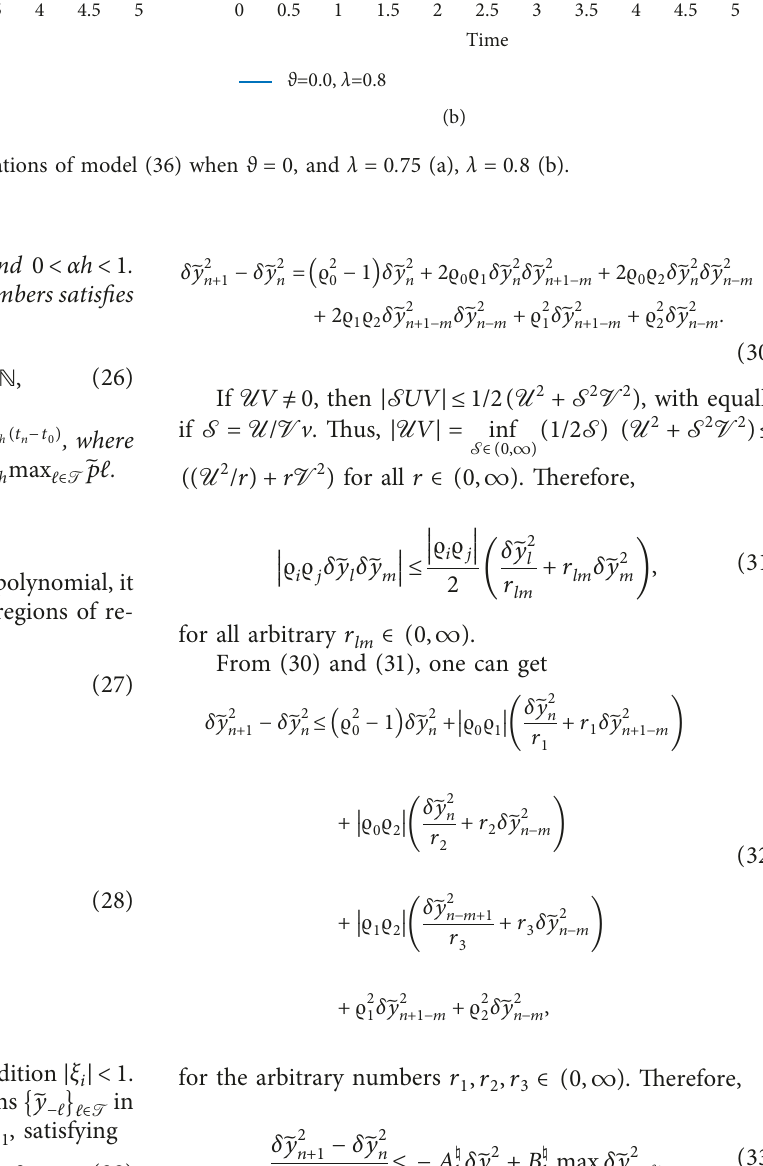
=0.75-1-0.8-0.6-0.4-0.200.20.40.60.81 ϑ =0.0, λ Figure 1: Numerical simulations of model (36) when ϑ � 0, and λ � 0 . 75 (a), λ � 0 . 8